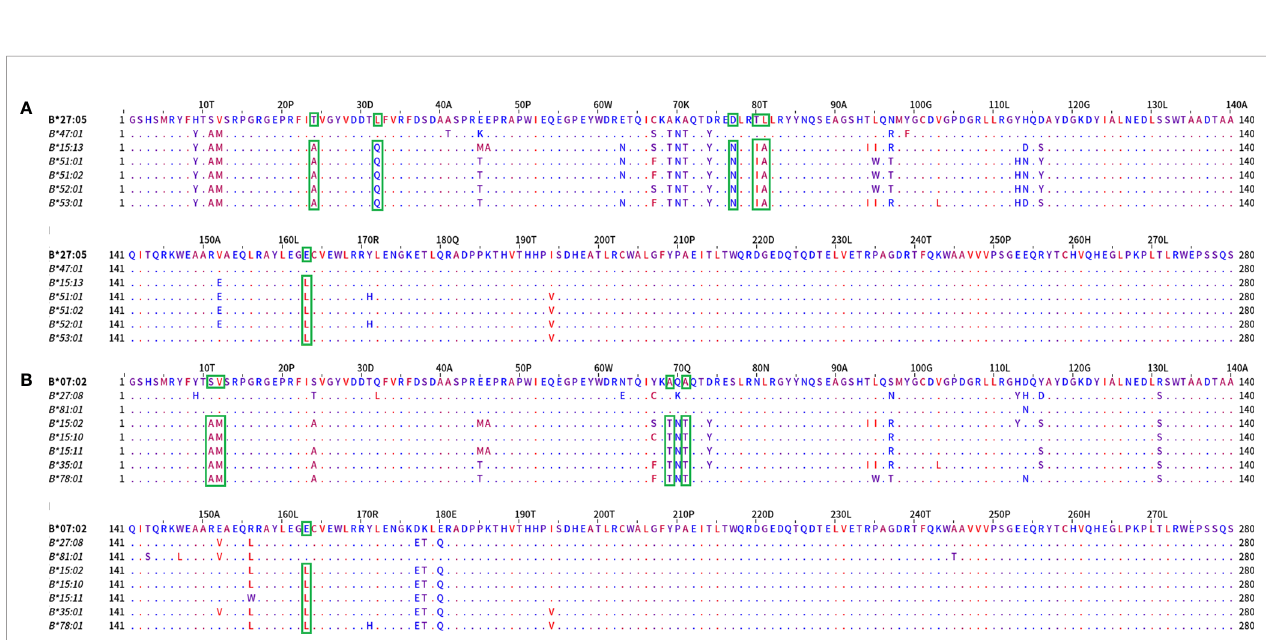
FIGURE 5 | Mature protein sequence alignments of distantly PCA de fi ned groups of HLA-B antigens. Upper panel (A) represents the most distantly related alleles grouped according to PCA and Bw4 belonging alleles. Residues are colored according to the hydrophobicity scale of Kyte, J., and Doolittle, R.F. This scale can be used for identifying surface-exposed regions. The most hydrophobic residues are colored red, and the most hydrophilic ones are colored blue. Changes in the patterns of amino acid conservation between group 1 (B*27:05, B*47:01) and group 2 (B*15:13, B*51:01, B*51:02, B*52:01 and B*53:01) are enclosed in a green rectangle. Lower panel (B) represents the most distantly related alleles grouped according to PCA and the Bw6 groups. Changes in the patterns of amino acid conservation between group 1 (B*07:02, B*27:08, B*81:01) and group 2 (B*15:02, B*15:10, B*15:11, B*35:01, B*78:01) are enclosed in a green